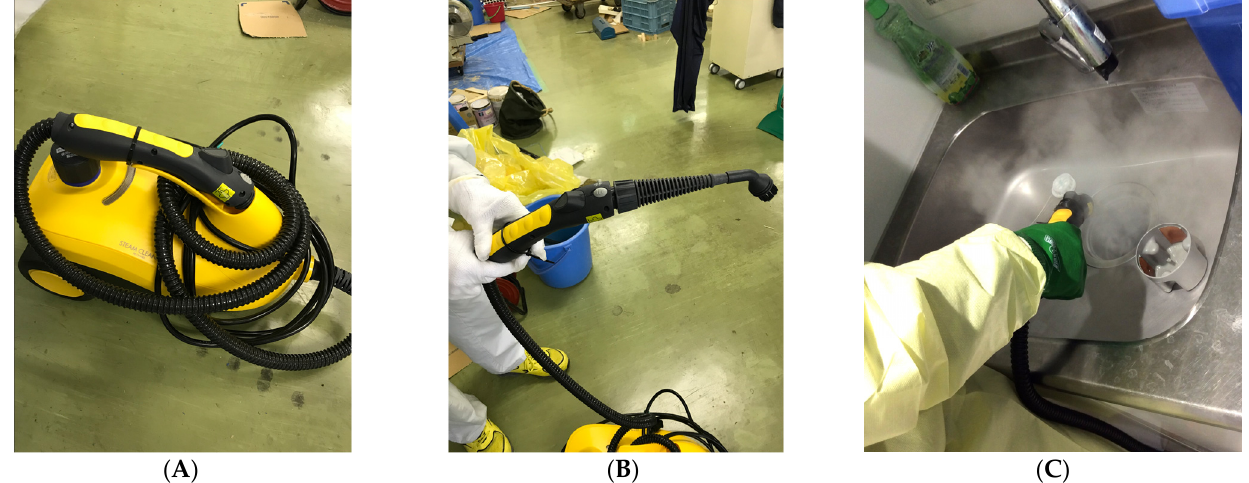
Figure 1. Disinfection of sinks contaminated with carbapenemase-producing Enterobacterales using a steam cleaner. ( A ) Body (of a machine); ( B ) Nozzle tip; ( C ) View of steam.